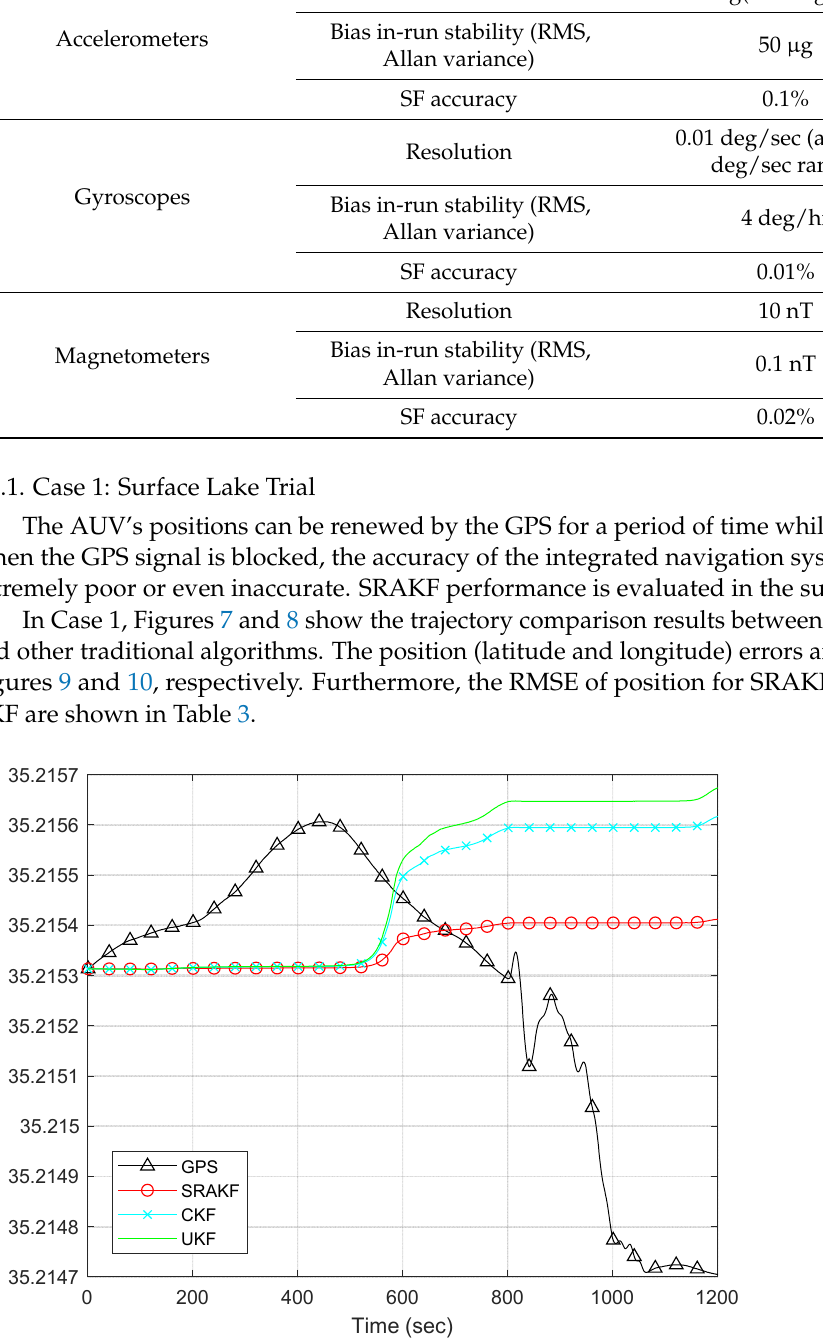
Figure 8. Longitude positions for the surface lake trial.